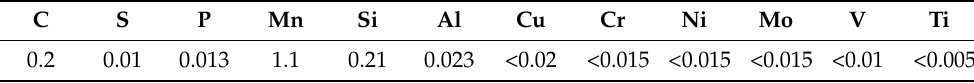
Table 1. Chemical composition of SA 516 Gr. 70 steel (weight in %)